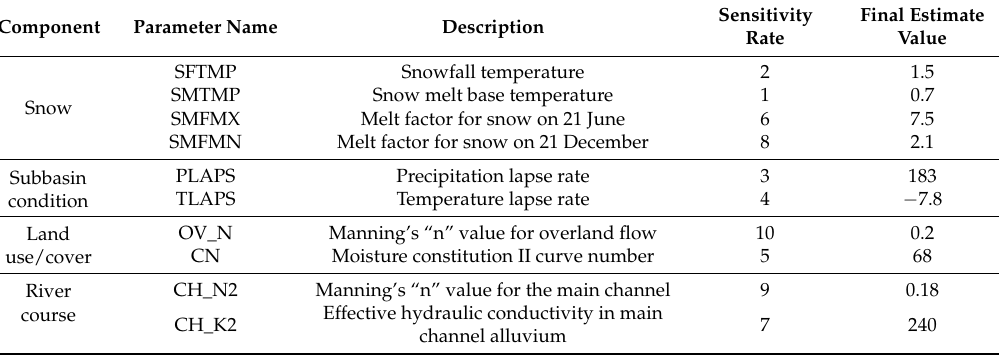
Table 2. Sensitivity rate and final calibration values of the top ten selected SWAT model